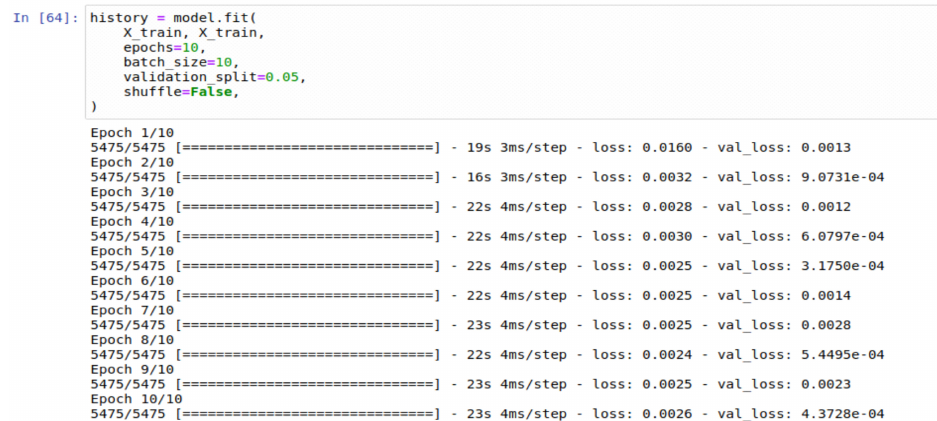
Figure 26. Training process of the model.